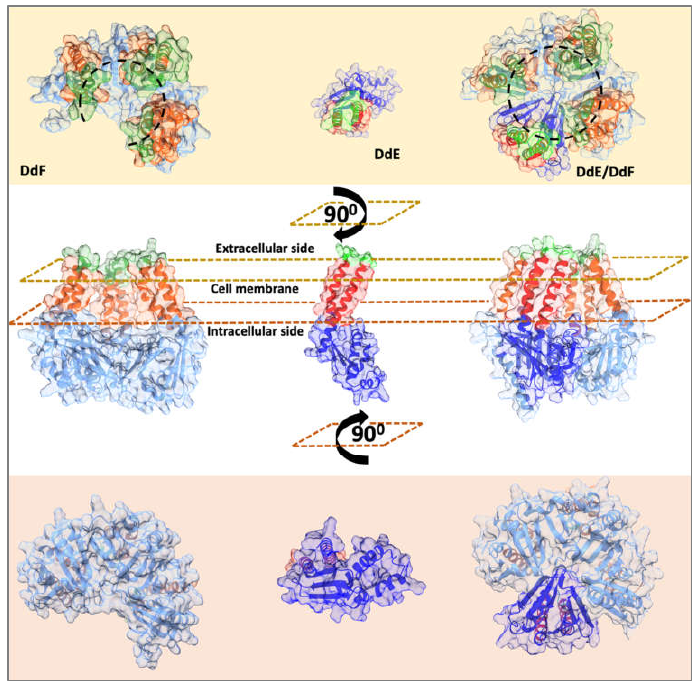
Figure 5. Predicted structures of DdF and DdE and their possible assembly into the DdE/DdF complex, a potential complete transmembrane channel. Transmembrane topology as predicted using DeepTMHMM is highlighted in shades of blue for intracellular regions, shades of red for transmembrane regions, and shades of green for extracellular regions. Models were visualized with UCSF Chimera.